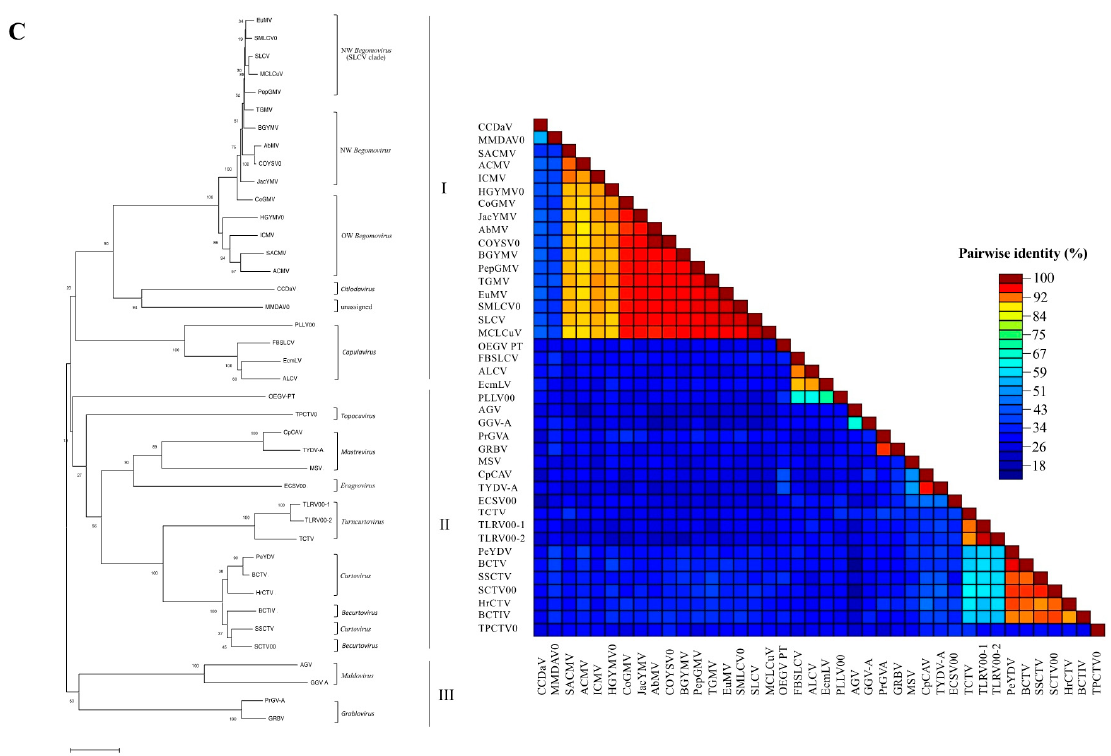
Figure 2. Phylogenetic trees constructed by the neighbor-joining (NJ) analysis from the alignment of the ( A ) OEGV PT full DNA-A (nt), ( B ) AC1/Rep (aa) and ( C ) AV1/CP (aa) from this study plus 39 sequences, with most representative geminiviruses including some isolates that had not yet been classified into genera, retrieved from the GenBank database. Virus genera, species and abbreviations, and GenBank accession numbers used in the NJ analysis are NW Begomovirus (SLCV clade); EuMV, SMLCV0, SLCV, PepGMV, MCLCuV, NW Begomovirus ; AbMV, COYSV0, TGMV, BGYMV, JacYMV, OW Begomovirus; CoGMV, HGYMV0, SACMV, ACMV, ICMV, Mastrevirus ; MSV, CpCAV, TYDV-A, Topocuvirus ; TPCTV0, Turncurtovirus ; TCTV, TLRV00-1, TLRV00-2, Curtovirus ; PeYDV, BCTV, HrCTV, SSCTV, Eragrovirus ; ECSV00, Capulavirus ; FBSLCV, EcmLV, ALCV, PLLV00, Becurtovirus ; BCTIV, SCTV00, Grablovirus ; PrGV-A, GRBV, Citlodavirus ; CCDaV, Maldovirus ; AGV, GGV-A, and unassigned MMDAV0. Multiple sequence alignments were generated using MEGA 7 and the neighbor joining (BioNJ algorithms), based on calculations from pairwise nucleotide (nt) and amino acid (aa) sequences distances for full genome (nt) or proteins (aa) analysis. Numbers above the lines indicate bootstrap scores out of 1000 replicates. Roman numbers indicate the groups clustered in each phylogenetic tree.